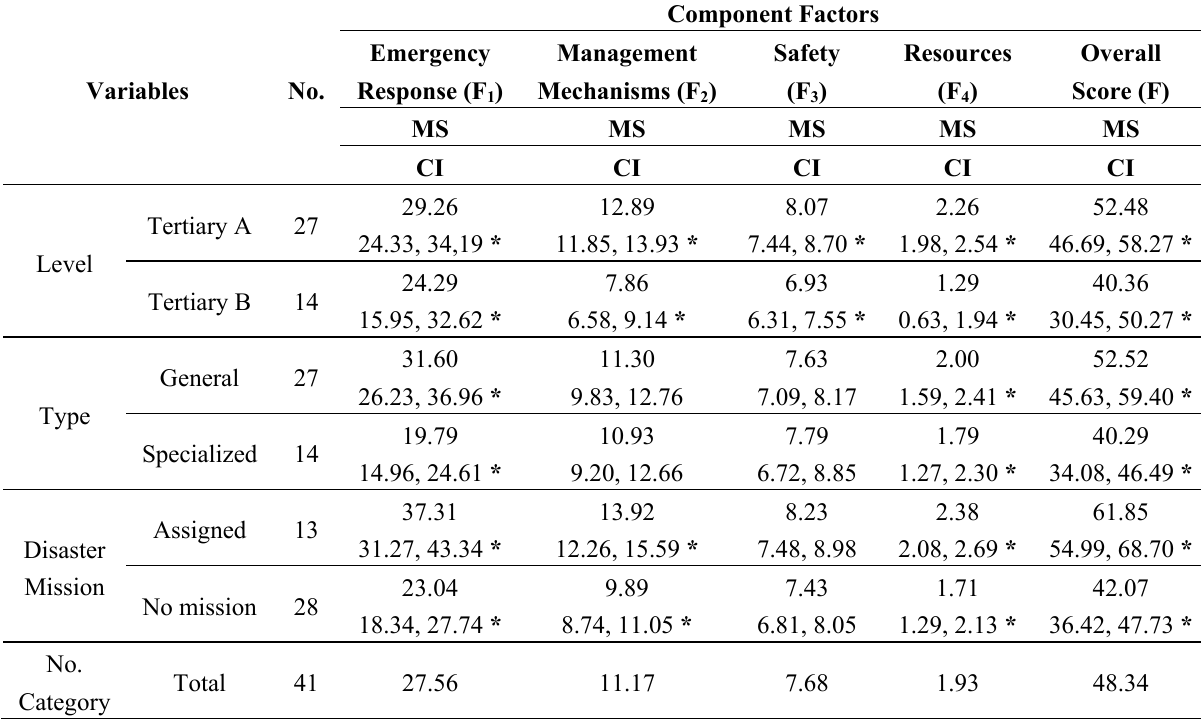
Table 3. Comparison of mean score (MS) and 95% of confidence interval of means (CI) of four factors of hospital resilience, using the hospital sample in Shandong, China,